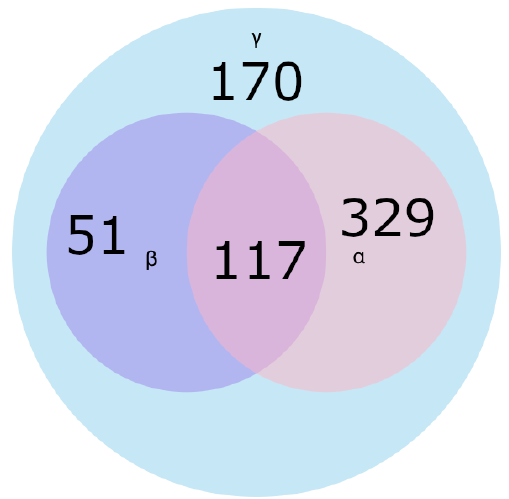
Figure 11. Venn diagram of channel sets during interval